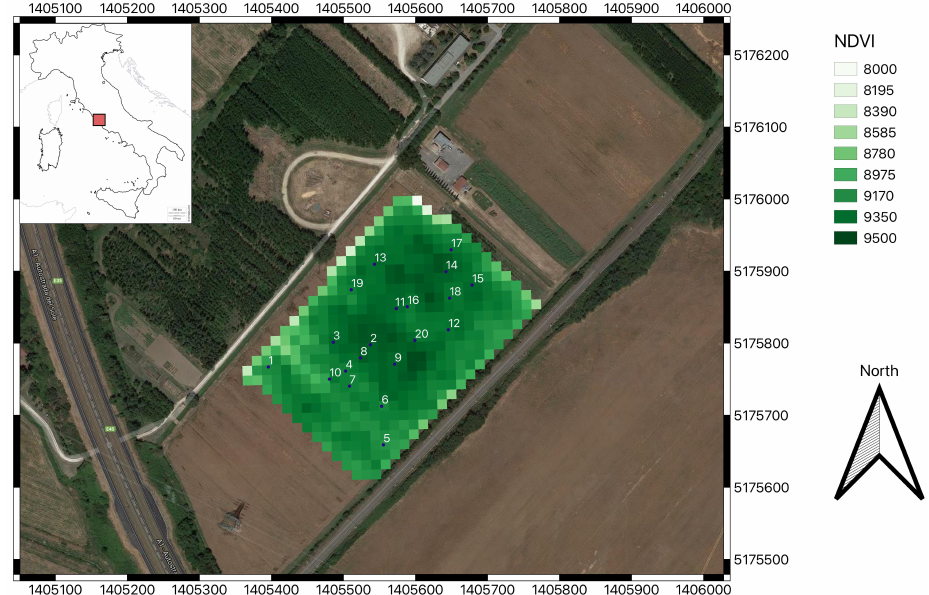
Figure 2. The study area is located in Italy (inset), region of Lazio, province of Rome, and it is part of the CREA experimental farm. Sentinel 2 Normalized Difference Vegetation Index (NDVI) map for the date 16 May 2019 is overlaid on the study area, the random sampling points are numbered 1 to 20; metric coordinates in WGS 84/UTM zone 33N coordinate reference system shown on